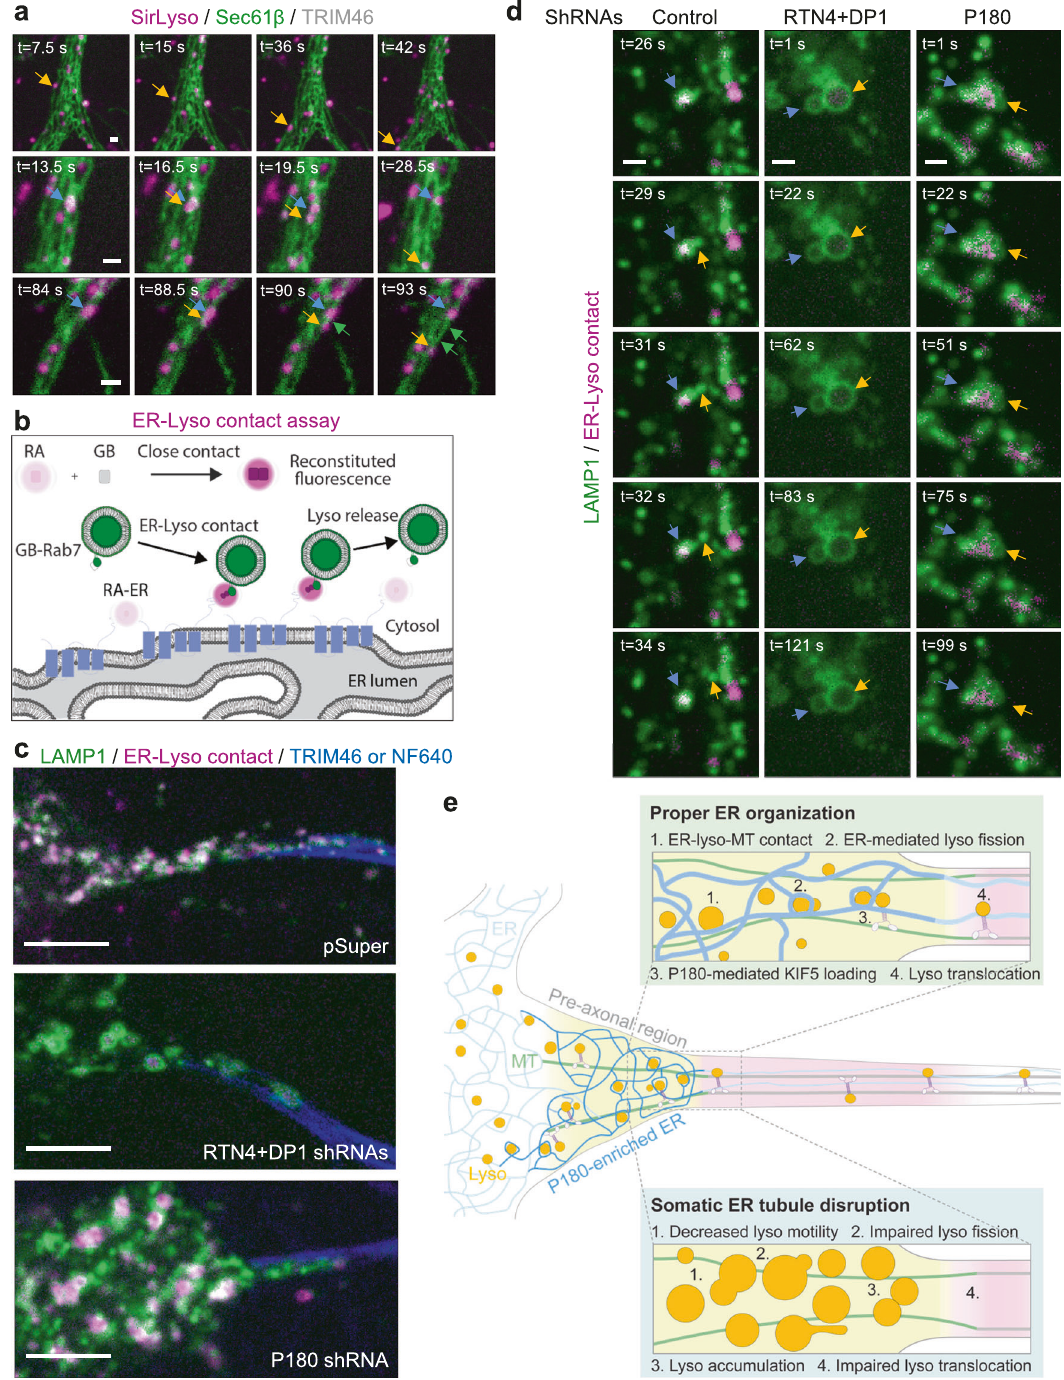
Fig. 7 Lysosome fi ssion and translocation associated to ER – lysosome contact sites at the pre-axonal region. a Representative still images of DIV6 neurons co-transfected with Sec61 β -GFP (green) and TRIM46-BFP and labeled for lysosomes with SirLyso (magenta) prior to imaging for 120 s every 1.5 s. Lysosome translocation along an ER tubule (top panels); Lysosome fi ssion at contact sites followed by lysosome translocation (middle panels); lysosome fi ssion and co-translocation with an ER tubule (bottom panels). See also Supplementary Movie 11. b Schematic representation of the reversible GB/RA contact assay used to visualize ER – lysosome contacts in live cells. GB and RA modules were tagged to RAB7 and protrudin, respectively. Only proximity of the two proteins enables reconstitution of fl uorescent protein at contact sites (magenta). c Representative still images of ER – lysosome contacts (magenta) at pre-axonal region from neurons co-transfected with control pSuper or shRNAs targeting RTN4 plus DP1 or shRNAs targeting P180 together with LAMP- GFP, GB-Rab7, RA-Protrudin, and TRIM46-BFP (blue) or labeled with NF640 (blue) prior imaging. d Representative still images of fusion events from neurons co-transfected and labeled as in ( c ). e Schematic representation of our proposed model of ER tubules regulating axonal lysosome availability at the pre-axonal region. Scale bars represent 1 µ m in ( a ) and ( d ) and 5 µ m in ( c